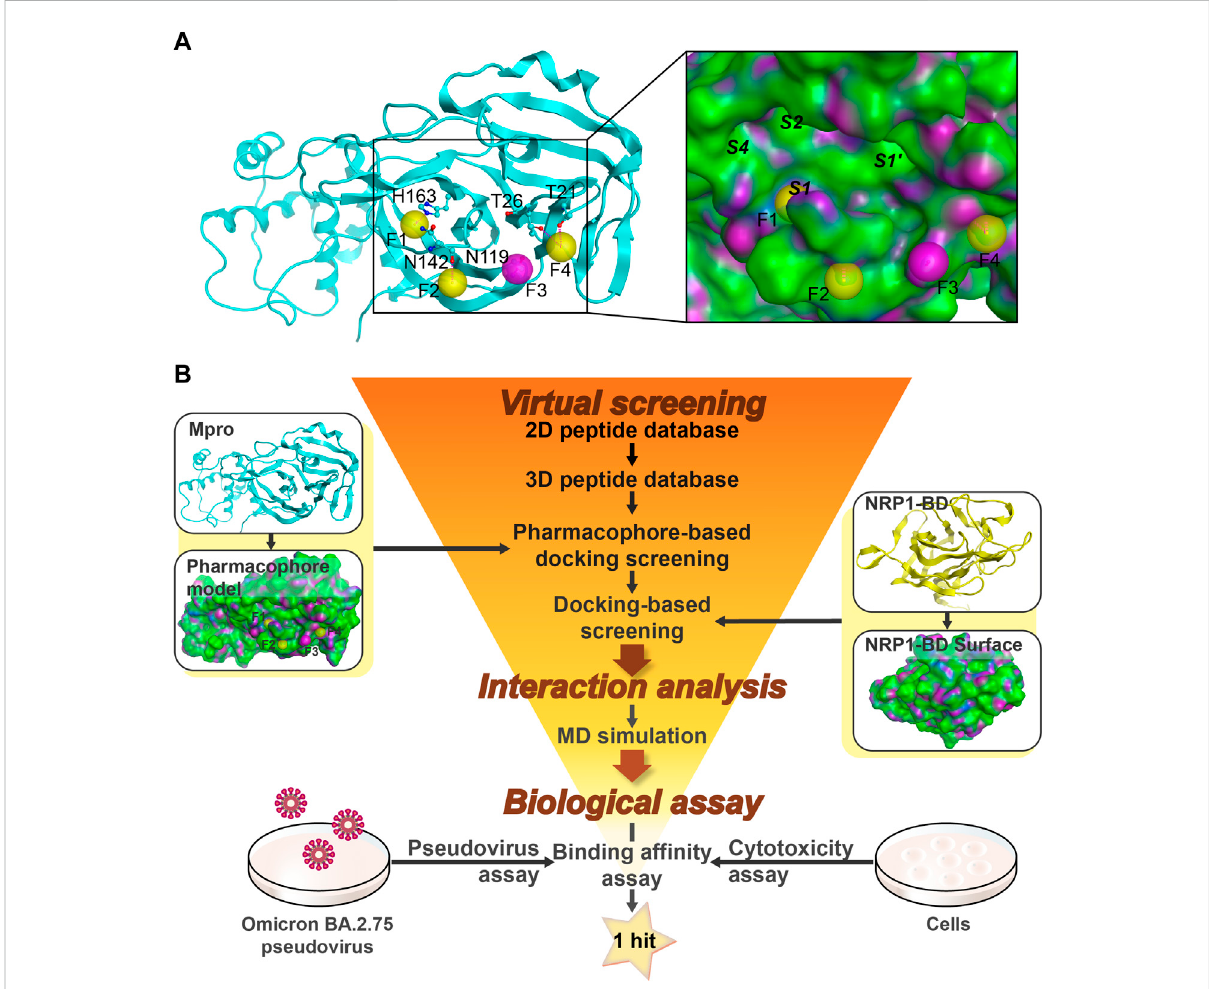
FIGURE 2 Identi fi cation of cyclic peptides targeting Mpro/NRP1. (A) Details of the Mpro-based pharmacophore model (F1, F2, and F4 are hydrogen-bond donor features, and F3 is a hydrogen-bond acceptor feature). (B) The fl owchart of virtual screening, interaction analysis, and biological assay for identi fi cationofdualMpro/NRP1-targetingpeptides.PharmacophorefeaturesofMproarerepresentedasspheres.Hydrogenbondsarerepresented by purple dotted lines. Italics indicate Mpro sub-pockets. Protein secondary structures are shown in line form. The surface of the Mpro and NRP1-BD are plotted by H-bonding (purple), hydrophobicity (green), and mild polar (blue)